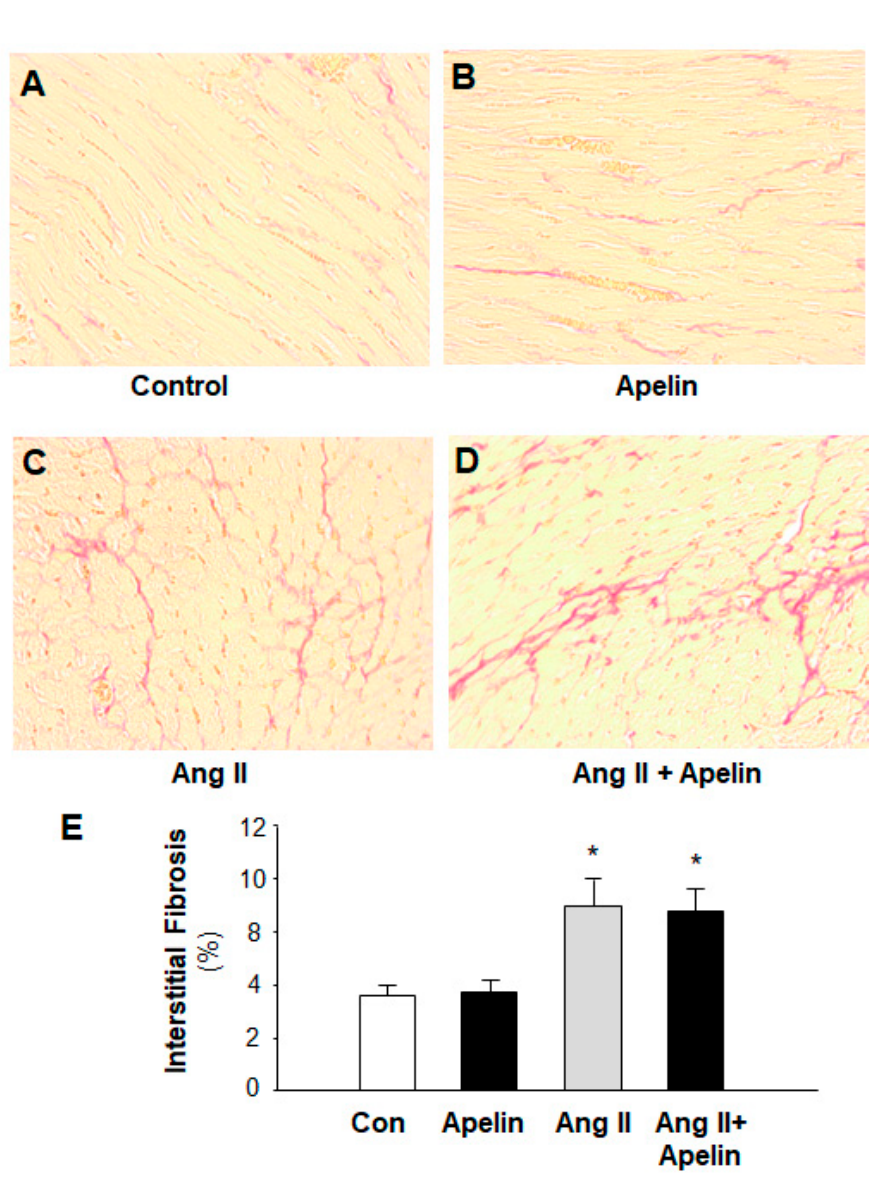
Figure 5. Effect of chronic subcutaneous infusions of apelin and Ang II on cardiac fibrosis. The cardiac Figure 5. E ff ect of chronic subcutaneous infusions of apelin and Ang II on cardiac fi brosis. The car- fibrosis was measured using Sirius Red in heart sections of rats that received chronic treatments with normal saline (control), apelin, Ang II, and Ang II plus apelin for two weeks. ( A – D ), representative microscopic images of the cross-section of the hearts stained with Sirius Red in the rats treated with saline ( A ), [pyr1]-apelin-13 ( B ), Ang II ( C ), and Ang II plus apelin ( D ). ( E ), bar graphs summarizing the cardiac fibrosis in the heart of those rats. Values are expressed as means ± SE ( n = 6 for each group). Significance was set as p < 0.05 (*), comparing with the